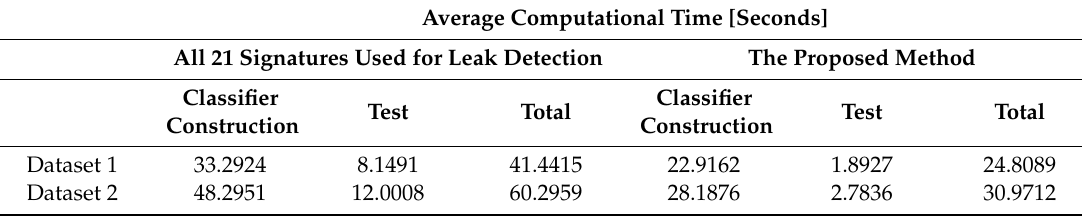
Table 7. Computational time comparison between the proposed and the conventional methods. Average Computational Time [Seconds] All 21 Signatures Used for Leak Detection The Proposed